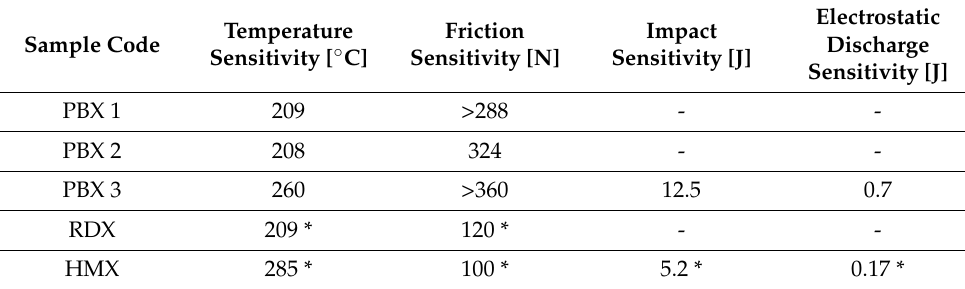
Table 5. Comparative summary of sensitivity tests.